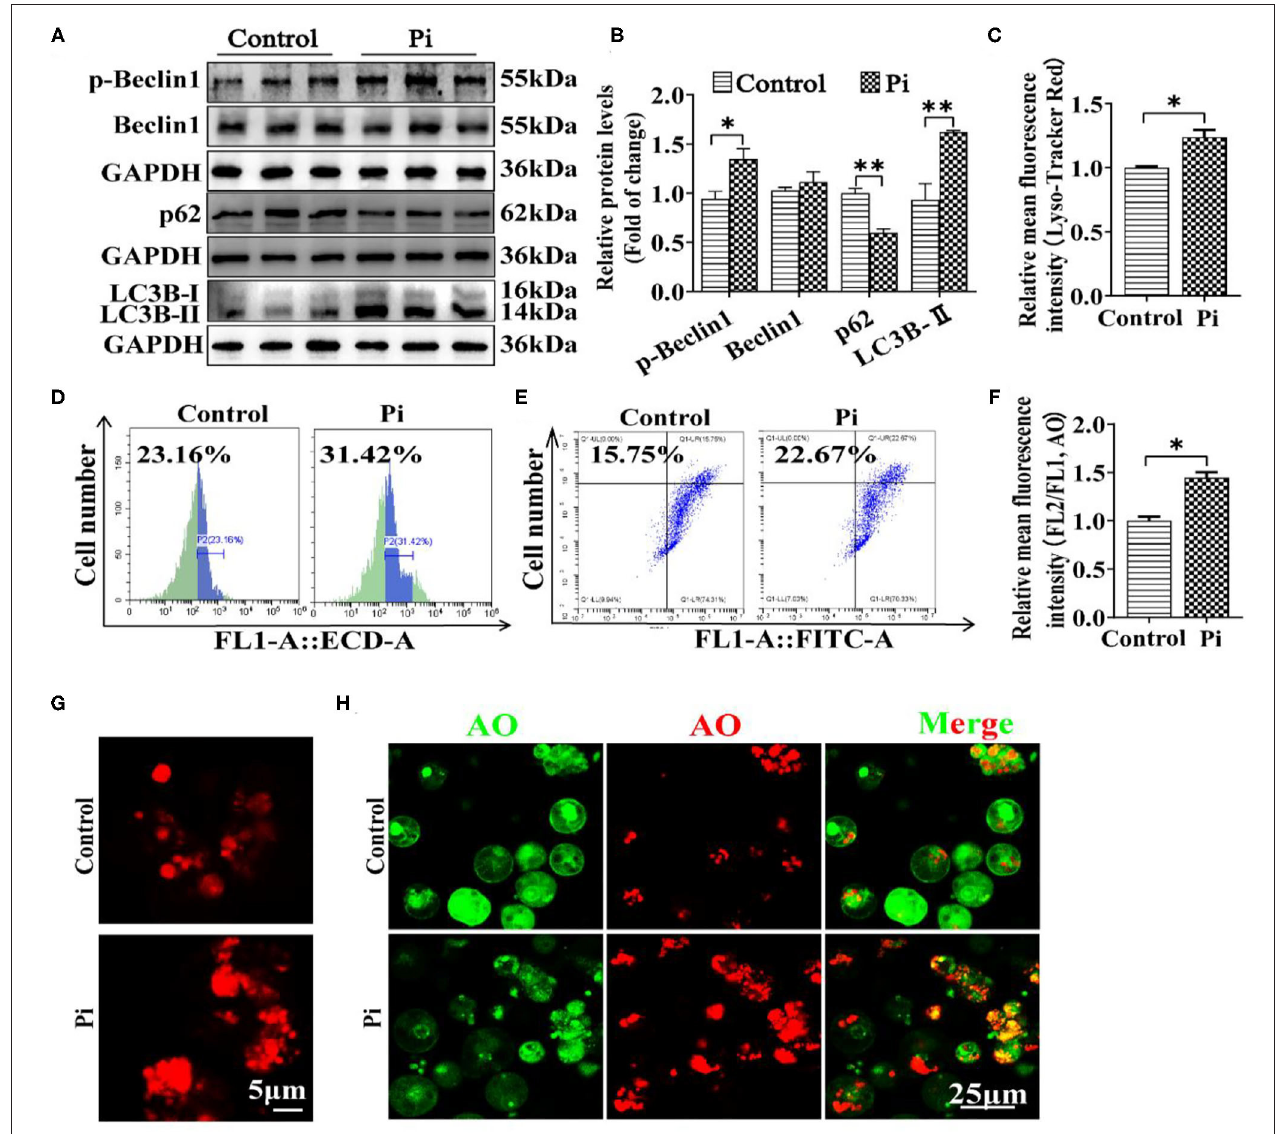
FIGURE 5 | Phosphorus incubation activated autophagy in tilapia hepatocytes. (A,B) Western blot analysis and quantification analysis of Beclin1, p-Beclin1, p62 and LC3B protein levels. (C) The Lyso-Tracker Red (50nM)-stained autolysosome was calculated by the flow cytometric analysis of the mean fluorescence intensity. (D) The presence of Lyso-Tracker Red-stained autolysosome was demonstrated by the flow cytometry analysis of the mean fluorescence intensity. (E) The presence of AO-stained autophagic vacuole was demonstrated by the flow cytometry analysis of the mean fluorescence ratio. (F) The AO (1 µ M)-stained autophagic vacuoles were calculated by the flow cytometric analysis of red/green (FL2/FL1) fluorescence ratio. (G) Lyso-Tracker Red (50nM)-stained. Scale bar, 5 µ m. (H) Representative confocal microscopic images of hepatocytes stained with acridine orange. Scale bar, 25 µ m. All data are expressed as mean ± S.E.M ( n = 3). P value was calculated by the Student’s t tests. * P ≤ 0.05, ** P ≤ 0.01, compared with control.